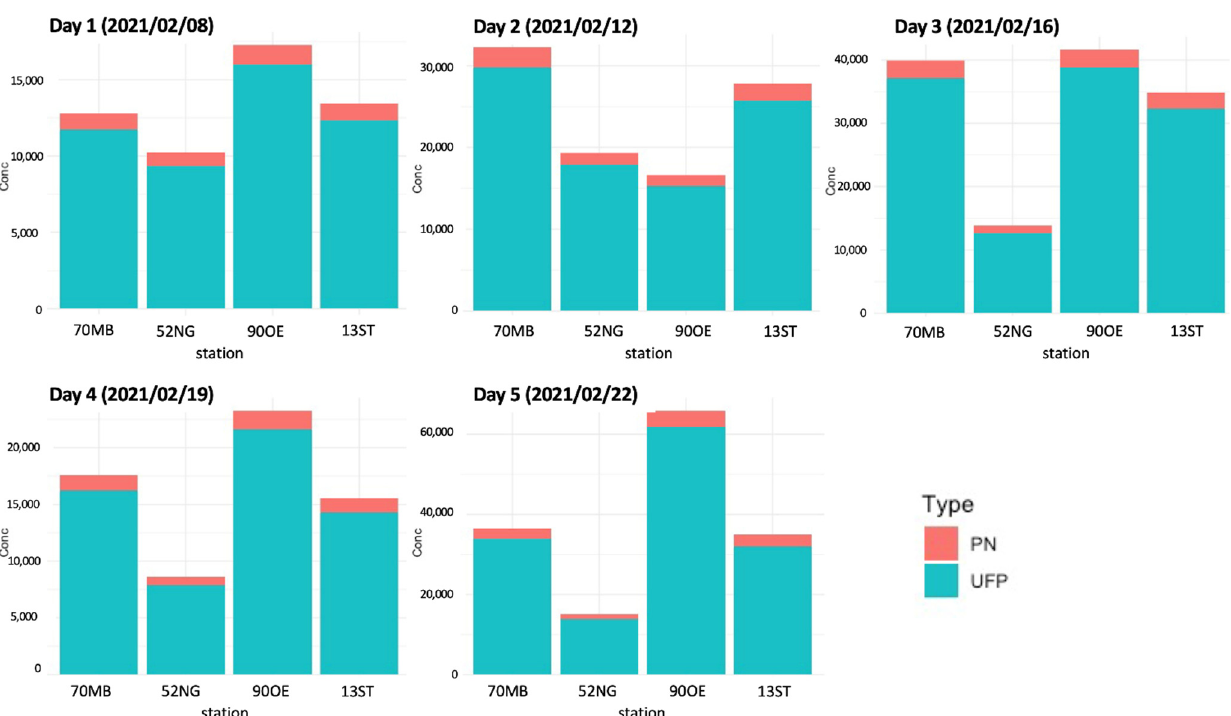
Figure 7. Modeled daily PN concentrations at the four measurement sites for the days 1–5 indicating the UFP share (turquoise) in total particle number counts (red).